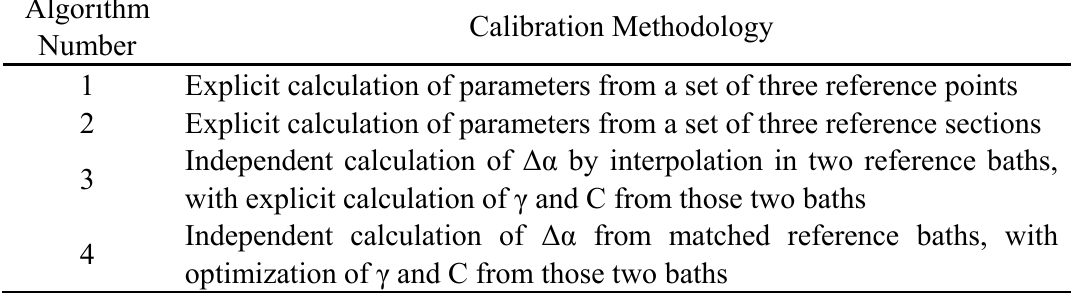
Table 1. Brief description of the four calibration algorithms presented in this